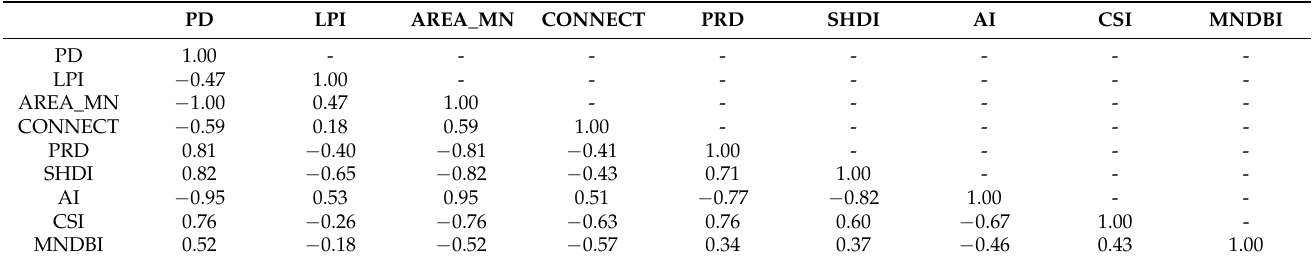
Table 3. Pearson’s correlation coefficients of B-IBI and V-IBI with the 23 candidate metrics used in